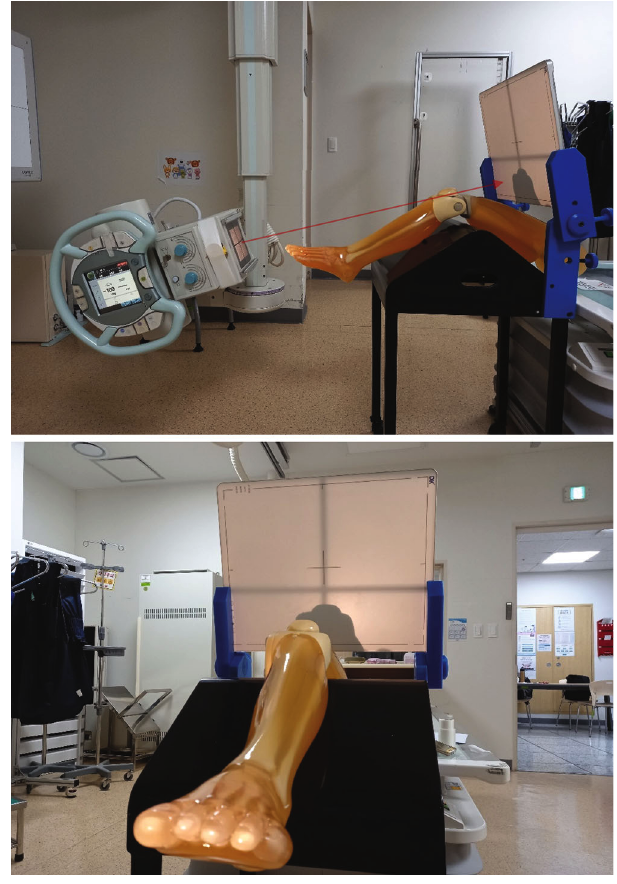
Figure 4: A phantom was mounted on the developed body of the PJR, and radiographs were taken in the tangential axial